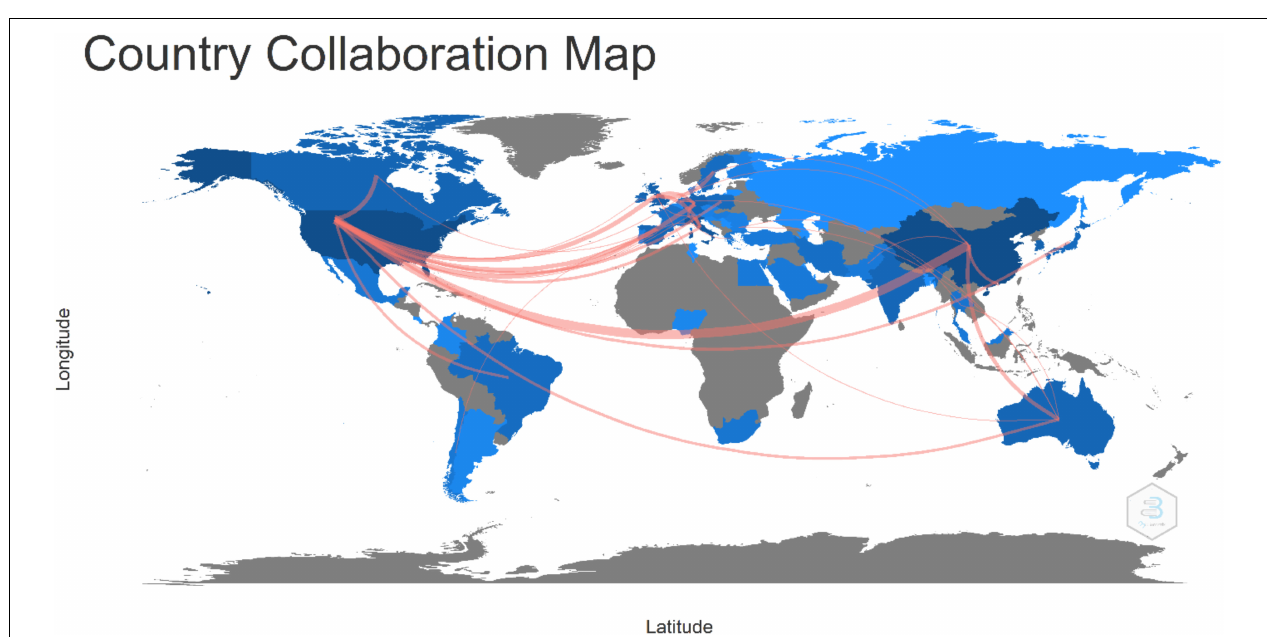
FIGURE 5 | International collaboration by country. Classification goes as multiple country publications (MCPs) in red and at a higher frequency, single country publications (SCPs) in blue.